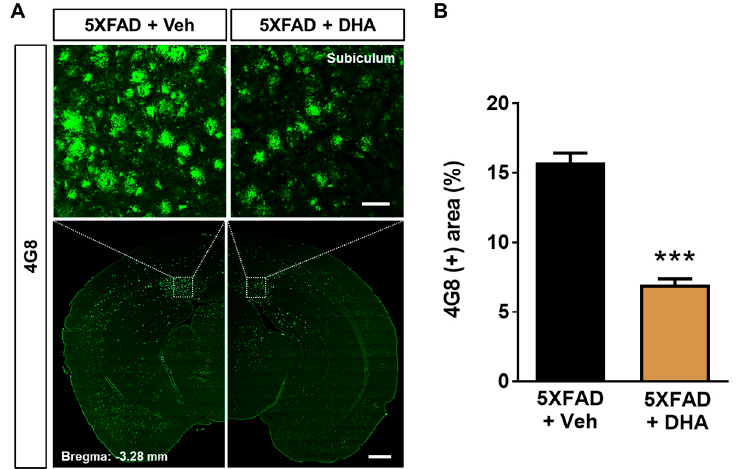
Figure 5. Effects of DHA on A β accumulation in the 5XFAD mice. ( A ) Immunofluorescence staining with a 4G8 antibody was performed to visualize the A β burden with or without DHA in the dorsal subiculum of 5XFAD mice (upper panel = 50 μ m, lower panel = 500 μ m). ( B ) 4G8-positive area coverage was significantly attenuated in the dorsal subiculum of DHA-treated 5XFAD mice compared to those in vehicle-treated 5XFAD mice. Data are presented as mean ± SEM (42 images/seven mice). *** p < 0.001.